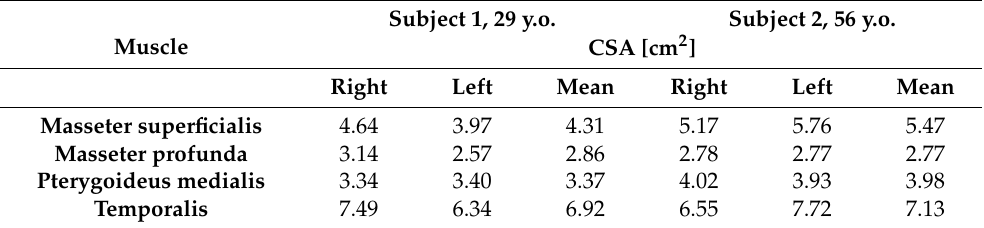
Table 1. An overview of both subjects’ measured maximum cross-sectional areas per muscle. Subject 1, 29 y.o.